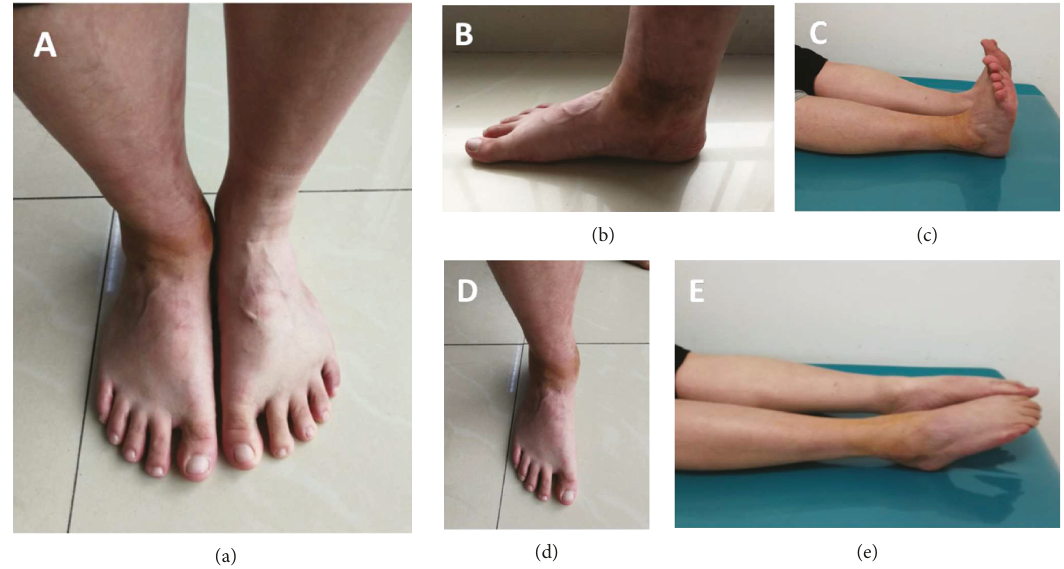
Figure 7: 12 months posttreatment: images of the patient standing on his feet. (a) Anteroposterior image of the patient standing on his feet. (b) Posteroanterior image of the patient standing on his feet. (c) Lateral image of the patient standing on his left feet. (d) Lateral image of the patient standing on his right feet. (e) Function of the patient fl exion and extension of his